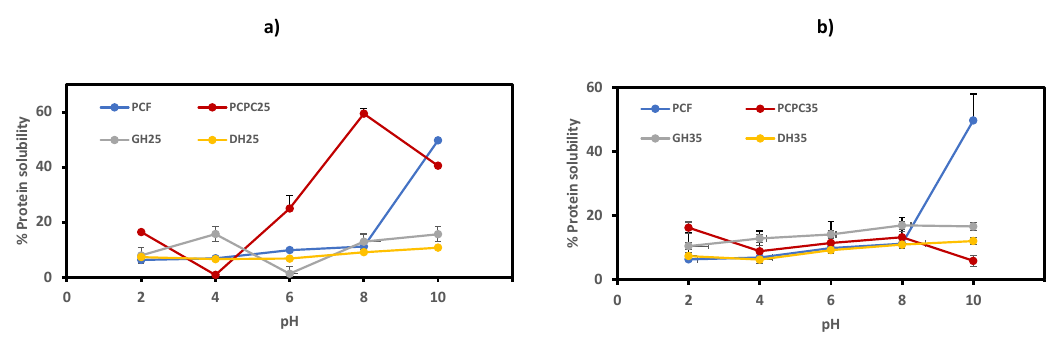
Figure 3. The %PS of PCF, PCPC25, PCPC35 and their hydrolysates at different pH ( a ) PCPC25 and gastric and duodenal hydrolysates; ( b ) PCPC35 and gastric and duodenal hydrolysates. PCF (purple corn flour), PS (protein solubility), PCPC25 (purple corn protein concentrate germinated for 5 days at 25°C), PCPC35 (purple corn protein concentrate germinated for 5 days at 35°C), PCF (purple corn flour), GH25 (gastric hydrolysate obtained from PCPC25), GH35 (gastric hydrolysate obtained from PCPC35), DH25 (duodenal hydrolysate obtained from PCPC25) and DH35 (duodenal hydrolysate obtained from PCPC35).